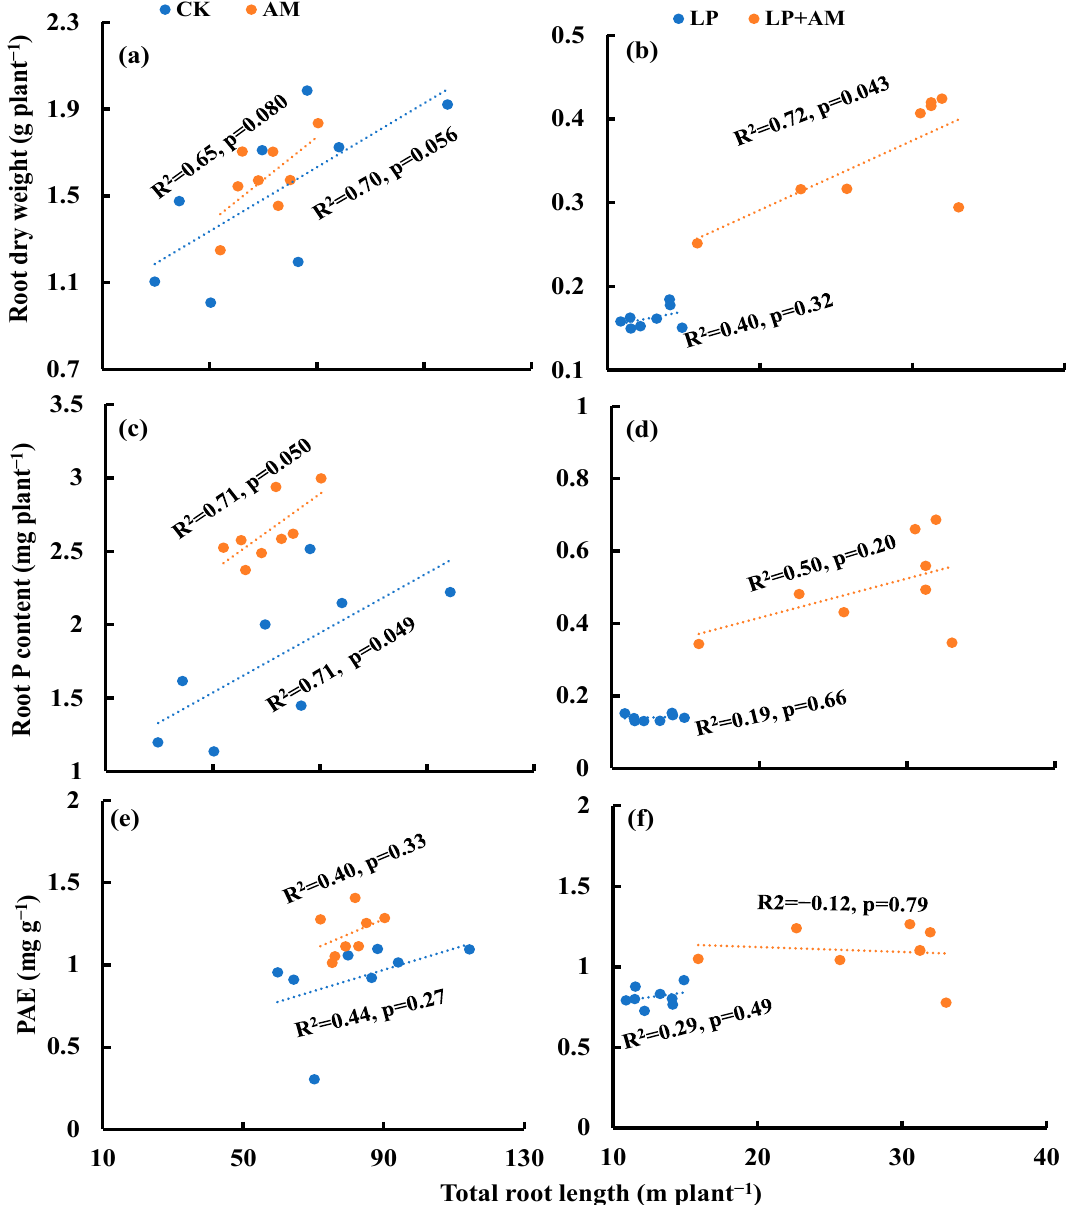
Figure 5. The relationship between total root length and root dry weight ( a , b ), root P content ( c , d ), and PAE ( e , f ) under four treatments. Note: Correlation coefficient of each trait from Pearson correlation analysis, data from each maize plant. PAE, phosphorus acquisition efficiency.